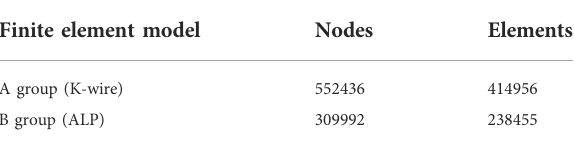
TABLE 1 Number of nodes and elements in fi nite element model. Number of nodes and elements in fi nite element